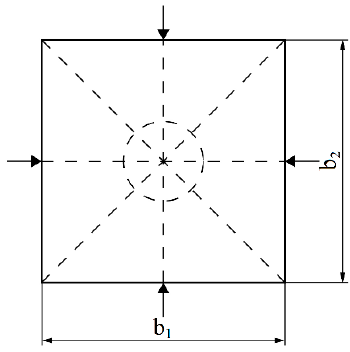
Figure 3. Scheme for determining the thickness of the sample.